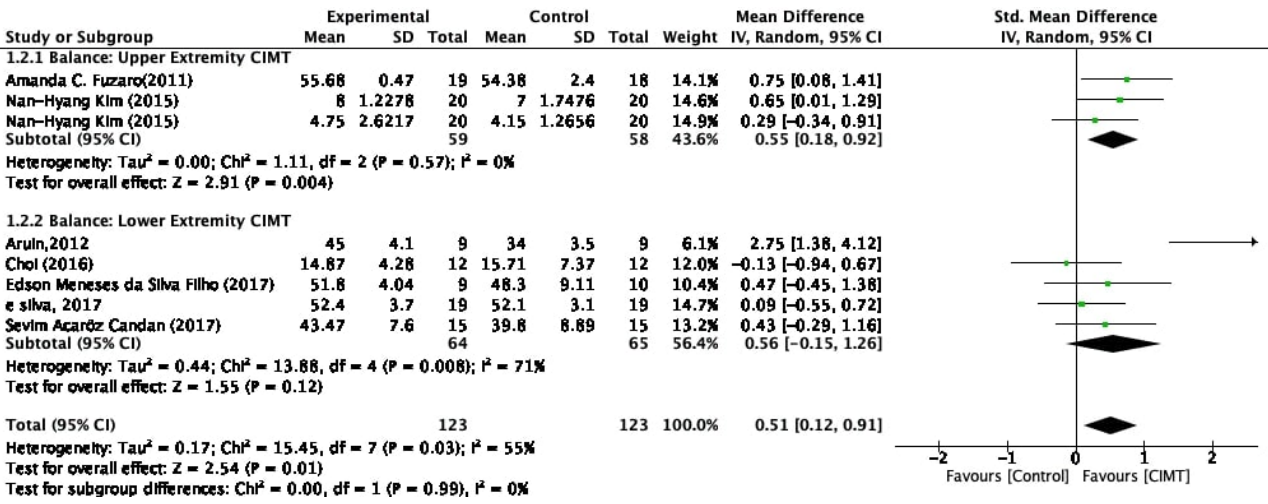
Figure 3. Meta-analysis results on the effect of CIMT on balance among stroke population.